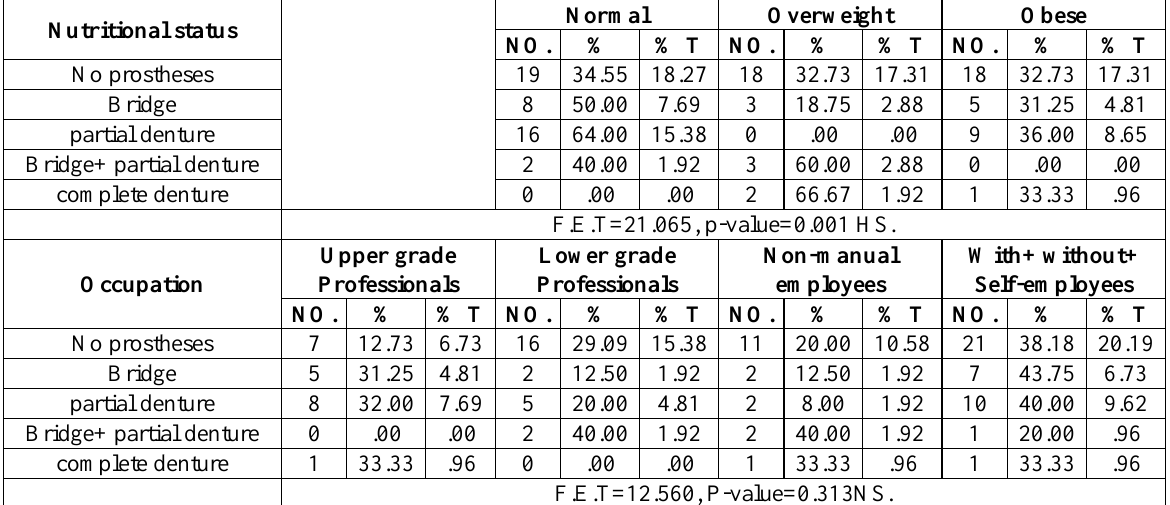
Table 2: Distribution of prosthetic status in upper arch by nutritional status and occupation. Nutritional